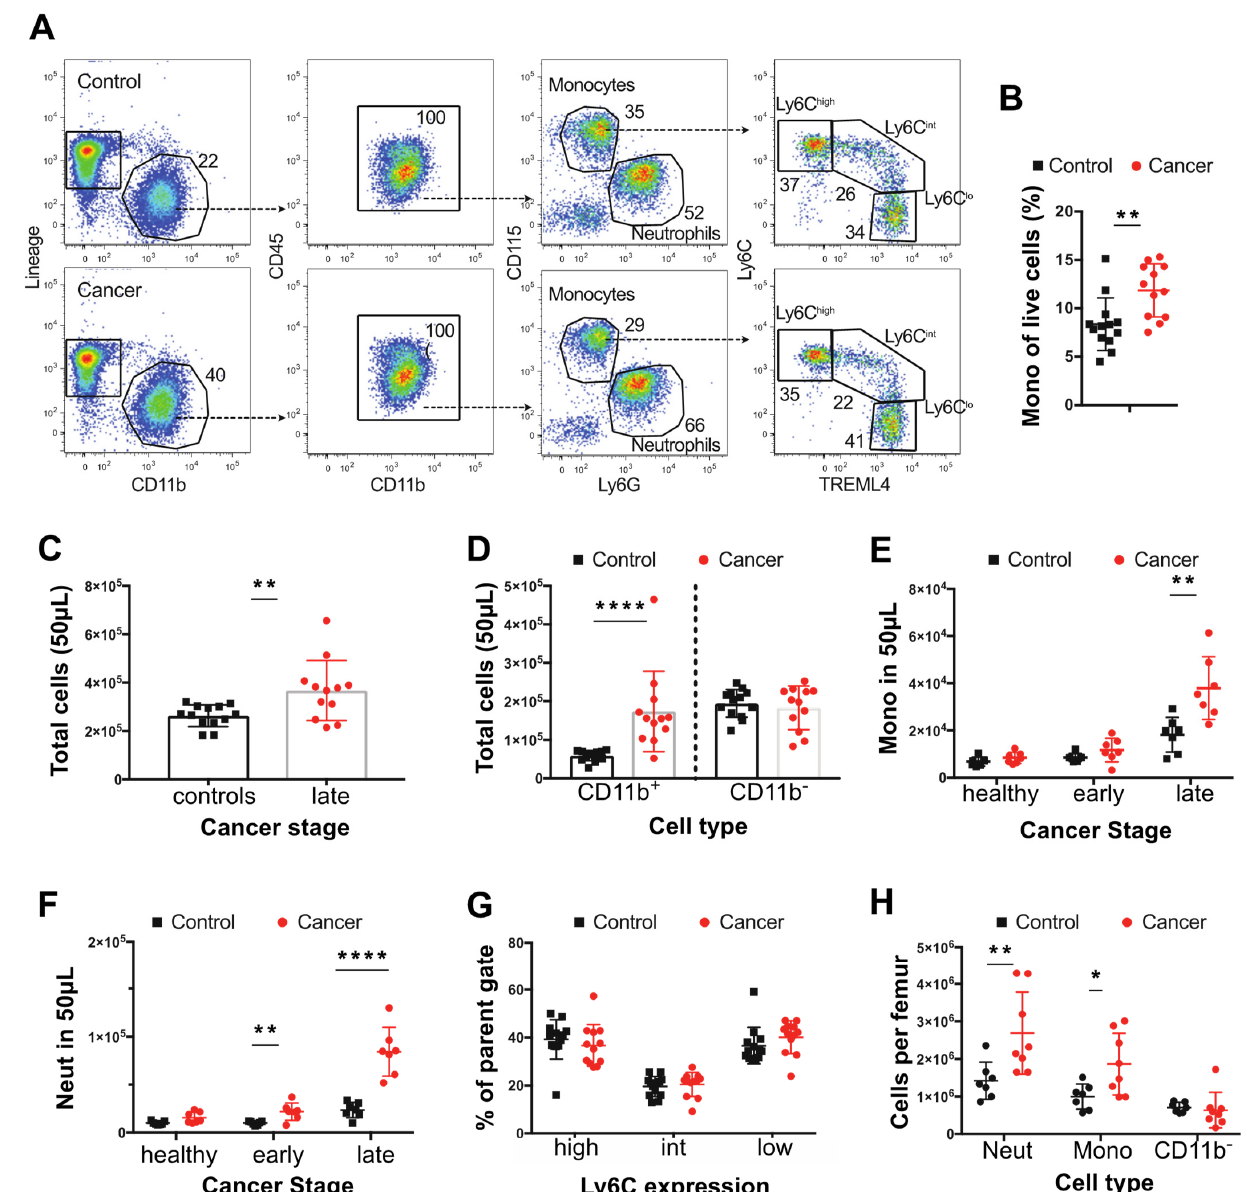
Figure 1. Changes in blood and bone composition of immune cells in PyMT tumor-bearing mice. ( A ) Representative dot plots showing identification of blood monocytes in control mice and mice with ~20 mm tumor (late) late-cancer. ( B ) Proportion of live blood leukocytes that are CD115 + CD11b + monocytes in mice with late-stage cancer versus controls. ( C ) Total cells in 50 µL of blood in mice with ~20 mm tumor (late) late-cancer (red dots N = 12) versus controls (black dots N = 13). ( D ) Total number of CD11b+ and CD11b- cells in mice with late-stage cancer versus controls. ( E ) Total circulating monocytes prior to tumor development (healthy), at onset of tumors (early), and at late stage versus control WT mice. ( F ) Total neutrophils (Neut) prior to tumor development (healthy), at onset of tumors (early), and at late stage of cancer. ( G ) Percentage (%) of monocytes subpopulations at late stage compared with control WT mice. ( H ) Neutrophils, monocytes, and lineage+ CD11b- cells per femur in mice with late stage cancer versus controls. Cancer samples are shown in red and age-matched controls in black. * p value < 0.05, ** p value < 0.01, **** p value < 0.0001, multiple t -test. Experiments were conducted in duplicates with littermate and co-housed groups of n = 6 (3 PyMT + ve) and n = 8 (4 PyMT + ve) in each replicate for the blood and co-housed groups of n = 6 (3 PyMT + ve) and n = 9 (5 PyMT + ve) for the bone.